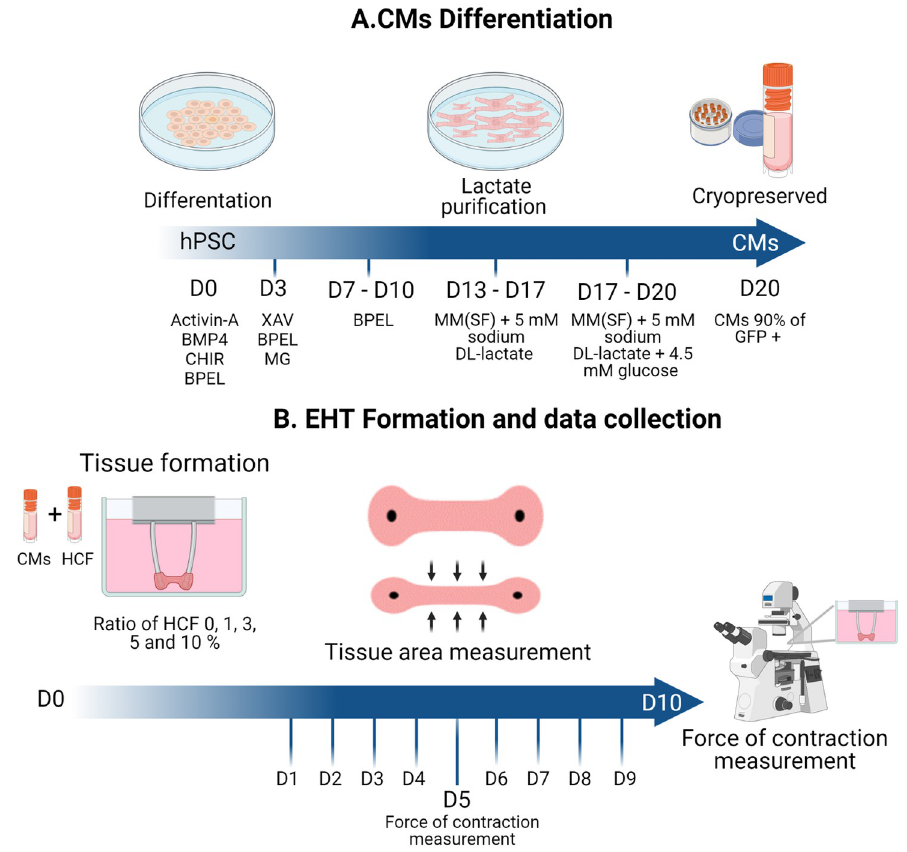
Fig 1. Experimental flow chart. (A) CMs differentiation steps from day 0 (D0), lactate purification at day 13 (D13) and cryopreservation of CMs at day 20 (D20). (B) EHT formation from frozen CMs and different ratios of HCF (0, 1, 3, 5 and 10%) at day 0 (D0); Follow up by data collection of the tissue surface area from day 1 (D1) until day 10 (D10) and contraction analysis carried at day 5 (D5) and day 10 (D10). hPSC = human embryonic stem cell; CMs = Cardiomyocytes; MG = Matrigel; MM = Maturation medium; SF = Serum free; HCF = Human adult cardiac fibroblast. Created with BioRender.com.